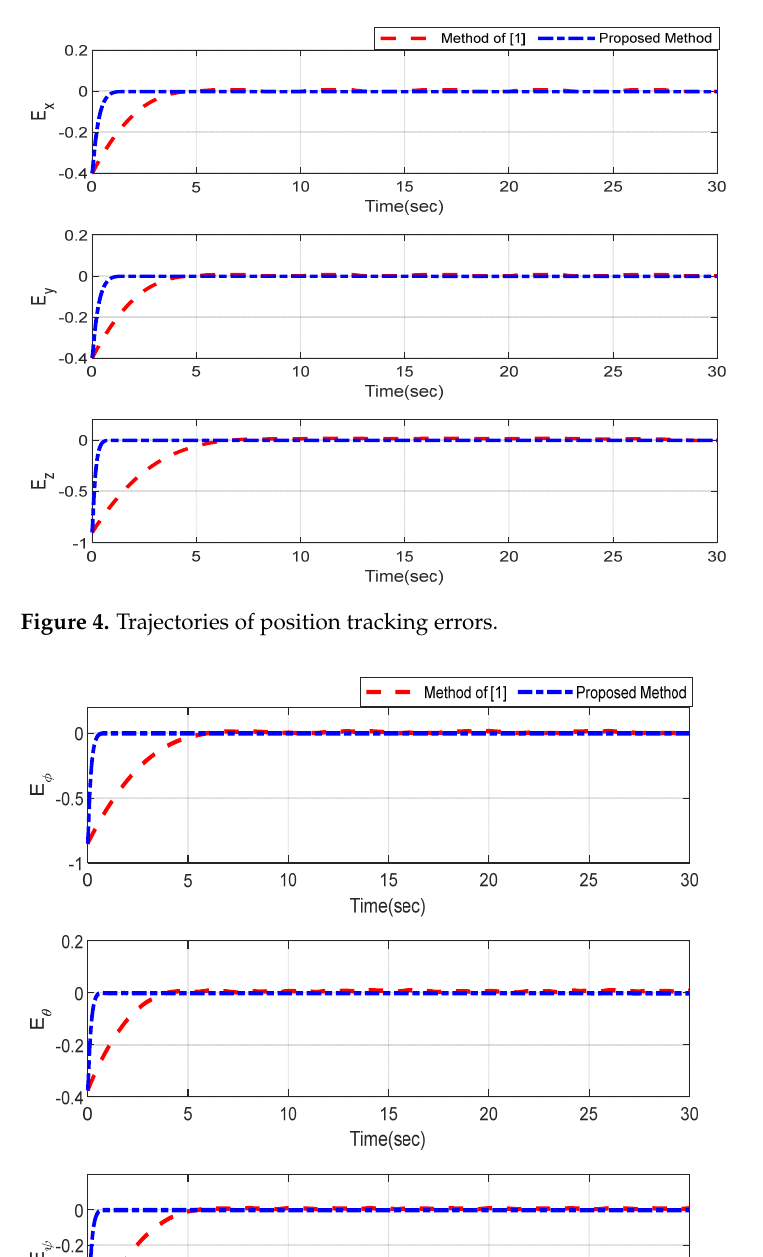
Figure 3. Attitude tracking of quadrotor using non ‐ singular TSMC method.